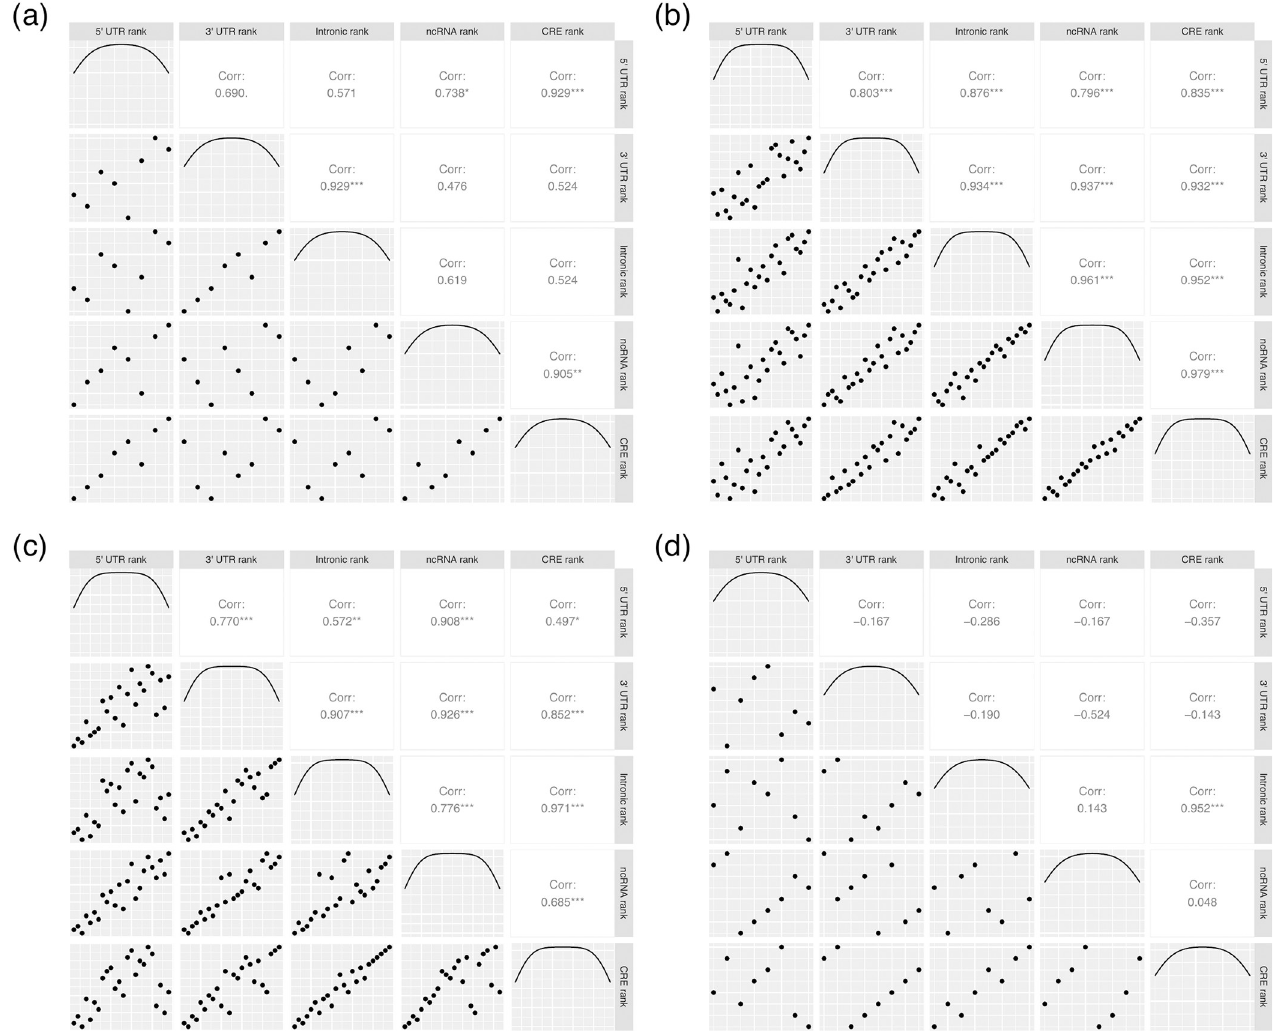
Fig 8. Correlation analysis of trinucleotide ranks (by their gBGC “boost” metric) within the 4 GC classes (a) 0%, (b) 33%, (c) 66%, and (d) 100%. Within the 33% and 66% GC classes, ranks are significantly correlated in all comparisons ( p < 0.01). This is not true of the 0% and 100% GC classes, correlation analyses within which are underpowered ( n = 8 trinucleotides in each class compared to 24 in the 33% and 66% classes). Correlation statistics were calculated using Pearson’s method. Underlying data can be found in S8 Data. CRE, cis -regulatory element; gBGC, GC-biased gene conversion; ncRNA, noncoding RNA.